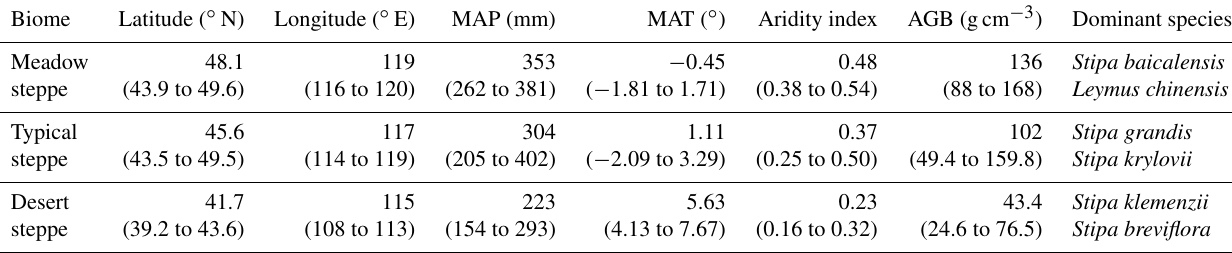
Table 1. Basic information of study sites. Biome Latitude ( ◦ N)